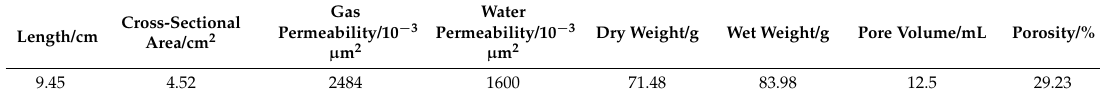
Table 6. The basic parameters of core.